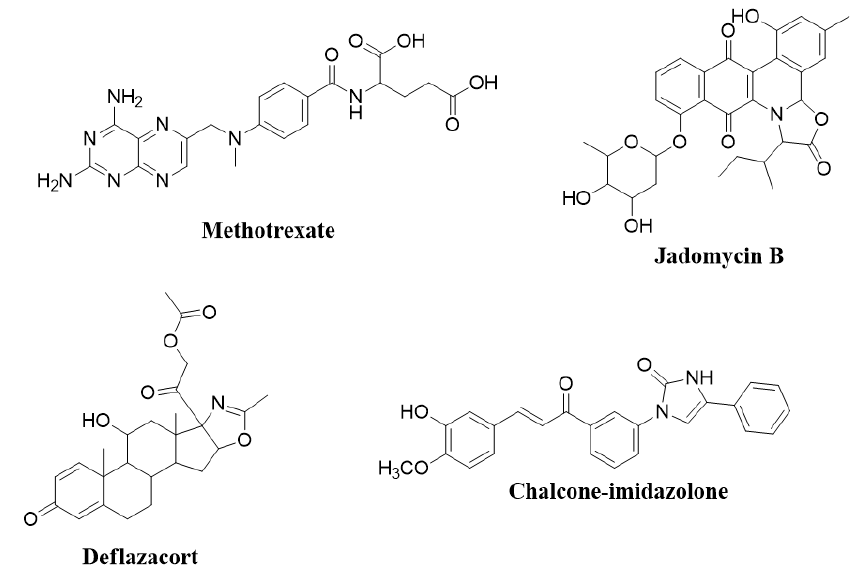
Figure 1. Bioactive molecules that contain imidazolone and oxazolone scaffolds.